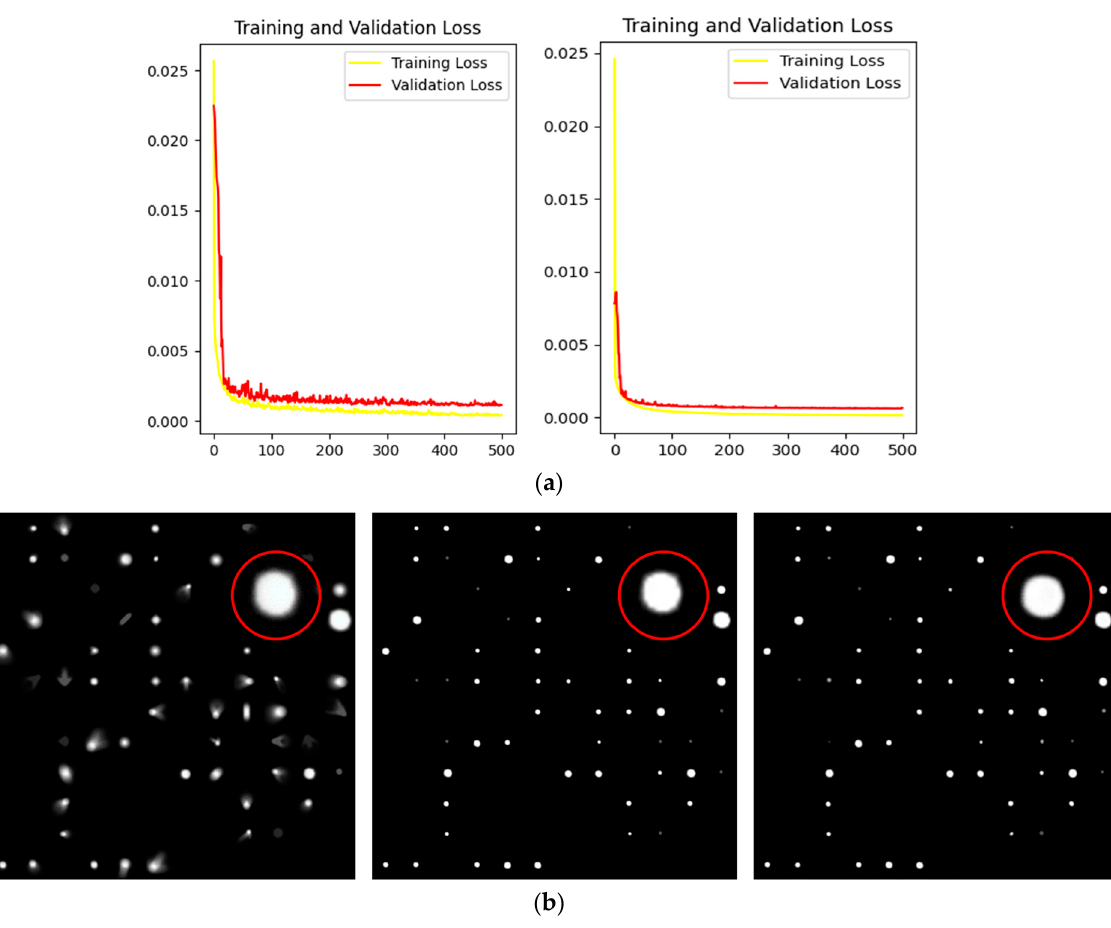
Figure 7. ( a ) Loss curves of 500 epochs were trained with L1 Loss and L2 Loss respectively; ( b ) the original drawing; L1 Loss was used to restore the image. Images recovered using L2 Loss.